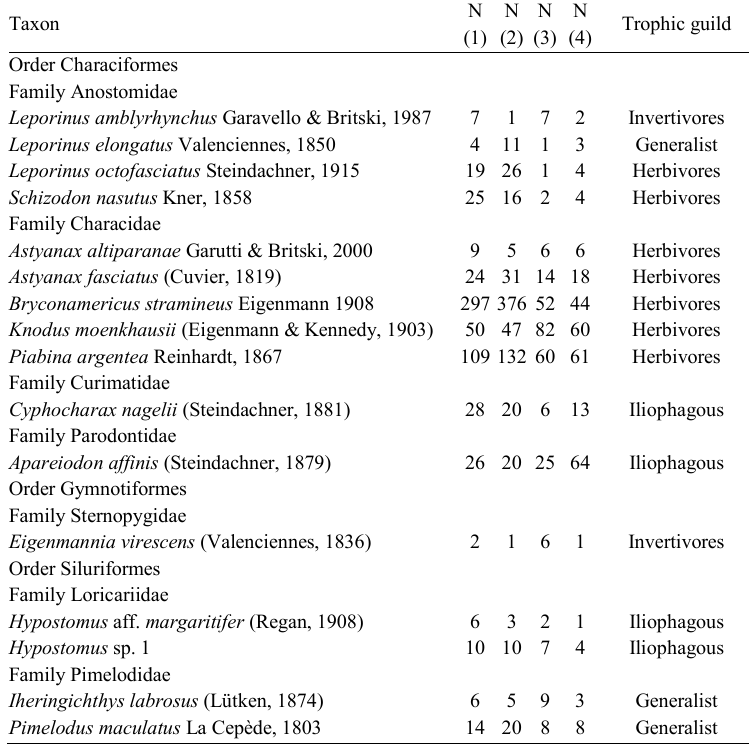
Table 1. Fish species and number of specimens analyzed per treatments. Trophic guilds were based on Gandini et al. (2012). N - number of individuals; Treatments: 1 - January stable flow, 2 - January peak flow, 3 - July stable flow, 4 - July peak flow.